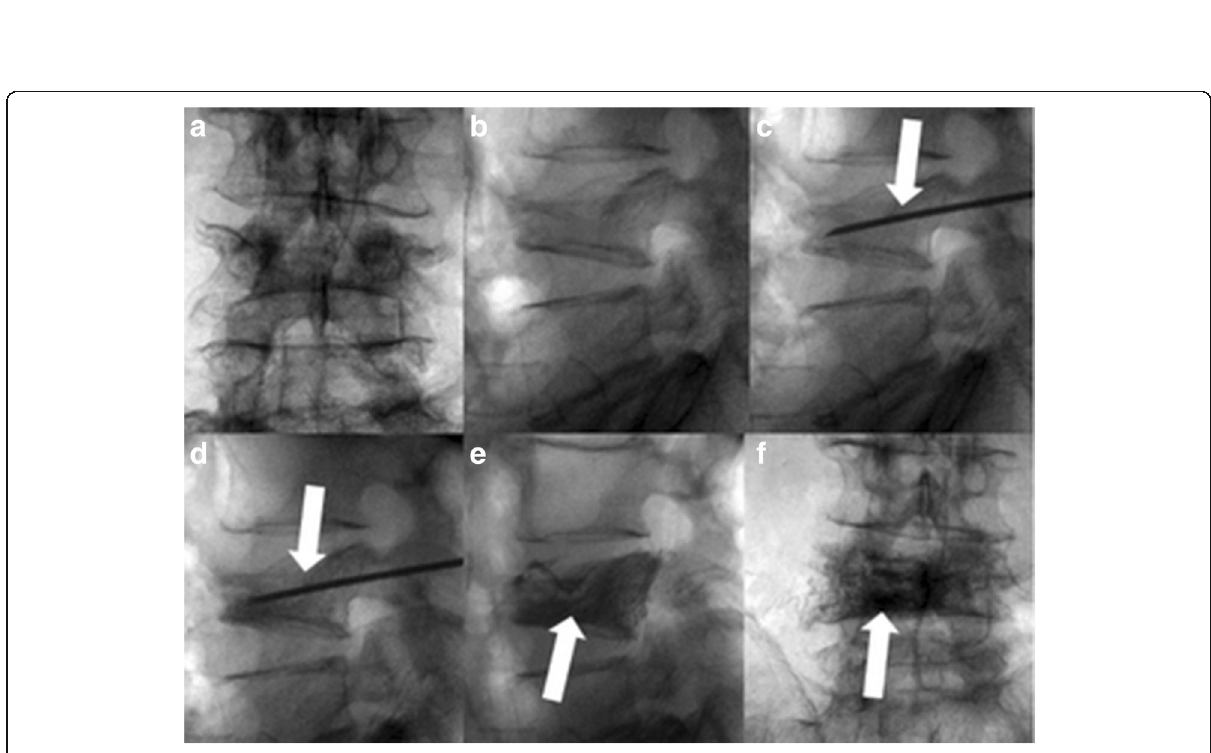
Fig. 2 Same case as shown in Fig. 1. Elastoplasty procedure: injection of VK100 in the fractured body (L4) using the transpedicular approach under fluoroscopic guidance. Preprocedural control x-rays; anteroposterior ( a ) and sagittal ( b ) view; fluoroscopy during transpedicular needle insertion (arrow) showing correct placement of the needle into the vertebral body ( c , d ); postprocedural control x-rays showing the good filling of L4 body (arrow, e , f